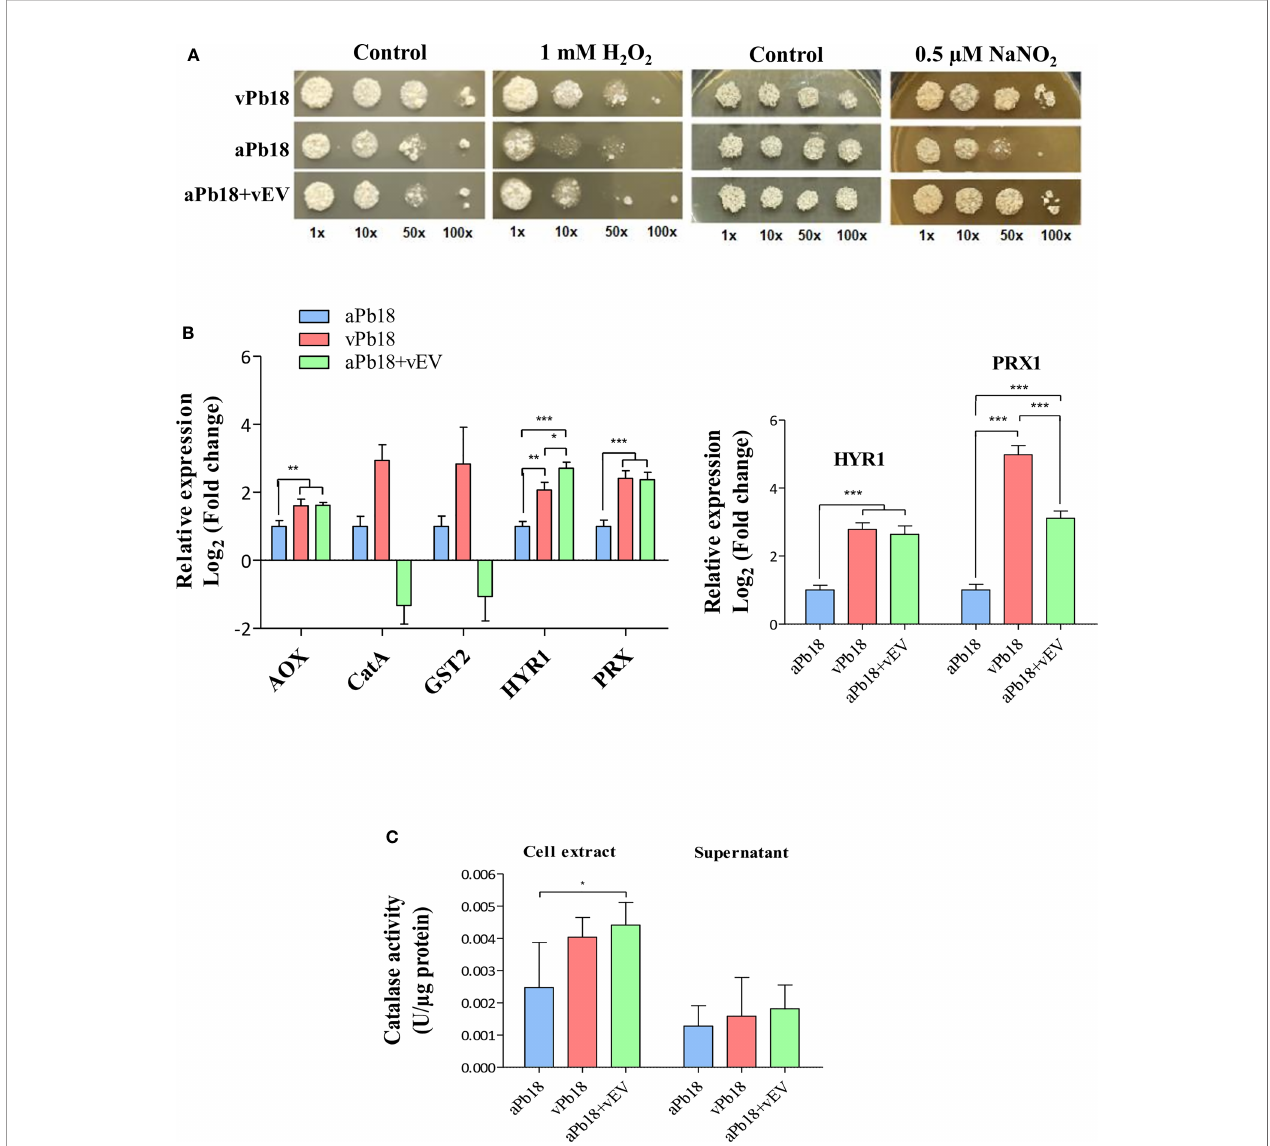
FIGURE 3 | Effect of vEV co-incubation with aPb18. (A) aPb18 yeast cells co-incubated with vEVs (aPb18+vEVs) were evaluated for viability under stress in serial spot tests in mYPD plates supplemented with increasing concentrations of H 2 O 2 (0, 0.1, 1, 5, and 10 mM) or NaNO 2 (0, 0.25, 0.5, and 1 mM). The results for 1 mM H 2 O 2 and 0.5 mM NaNO 2 are shown, where the differences were more prominent. The plates were incubated for 7 days at 36°C and the images are representative of biological triplicates with technical duplicates. Serially spotted vPb18 and aPb18 were used as controls. (B) Gene expression of aPb18 yeast cells previously co- incubated with vEVs (aPb18+vEVs) was tested before (left graphic) or after (right graphic) a 2-h stress with 10 mM H 2 O 2 . Total fungal RNA was extracted and used in RT-qPCR of stress-related genes, as indicated. The a -tubulin gene was used as internal control in the comparative Ct strategy. The expression value for aPb18 cells was used as reference (1.0). (C) aPb18 yeast cells previously co-incubated with vEVs (aPb18+vEVs) were stressed for 2 h in 10 mM H 2 O 2 and intracellular (cell extract) and secreted (supernatant) catalase activity was measured. vPb18 and aPb18 were used as controls in all experiments, which were carried out in triplicates. The standard deviations are shown with bars and statistically signi fi cant results are indicated as * p < 0.05, ** p < 0.01, and *** p <